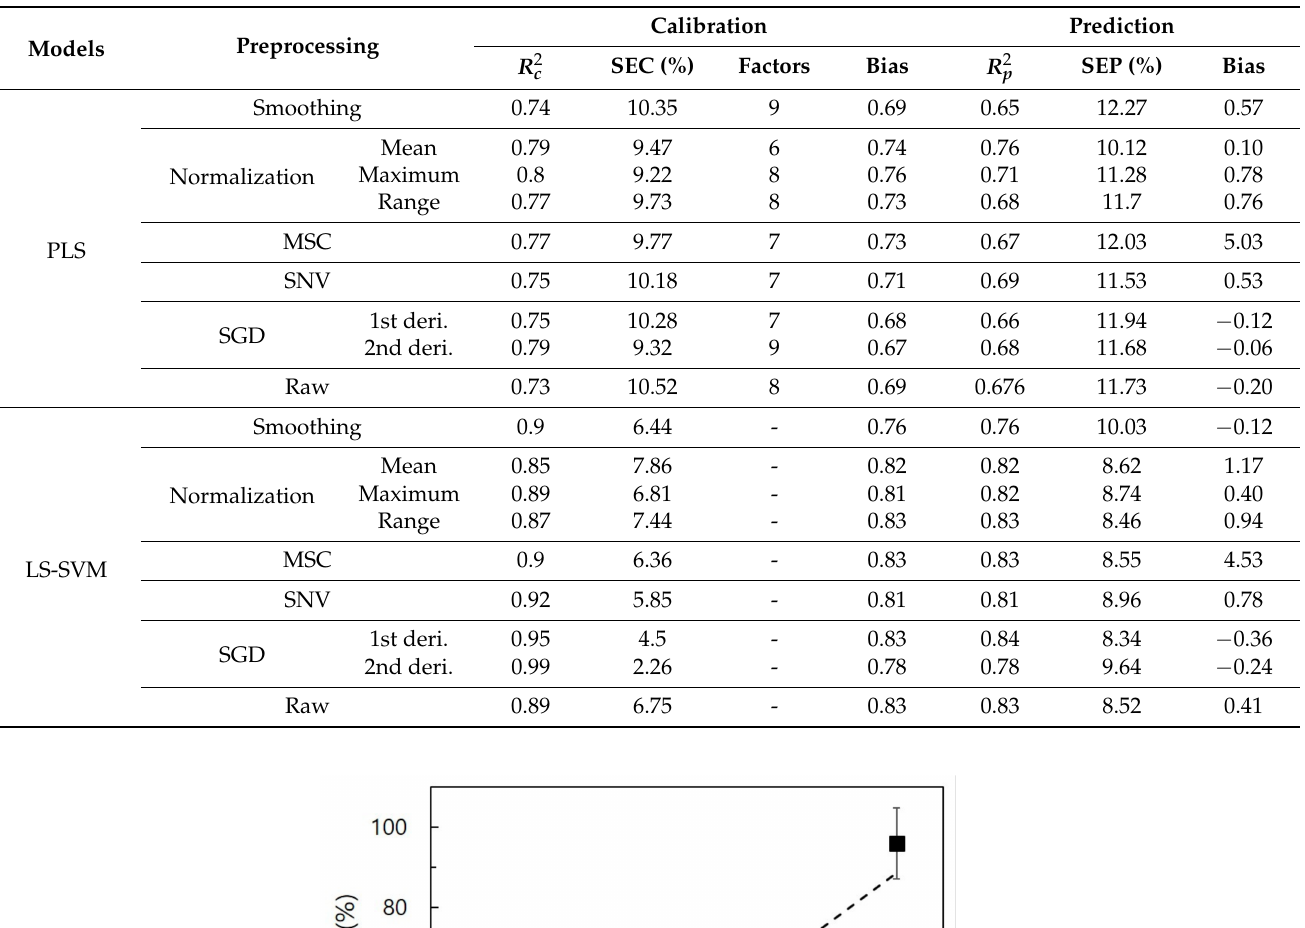
Table 2. FWC prediction outcome for OF mixture samples from EW region.